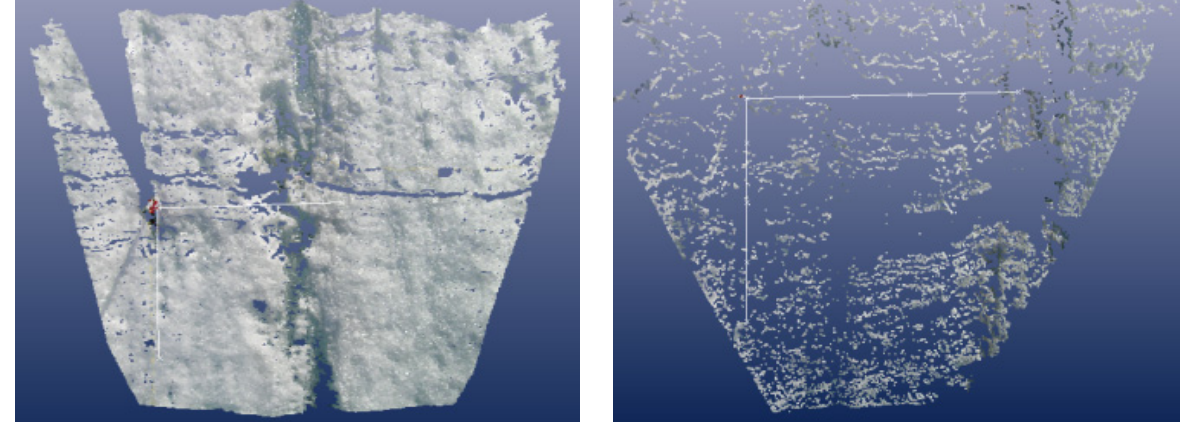
Figure 5. Top view of the 1 m 2 (left) and 4 m 2 (right) point clouds.